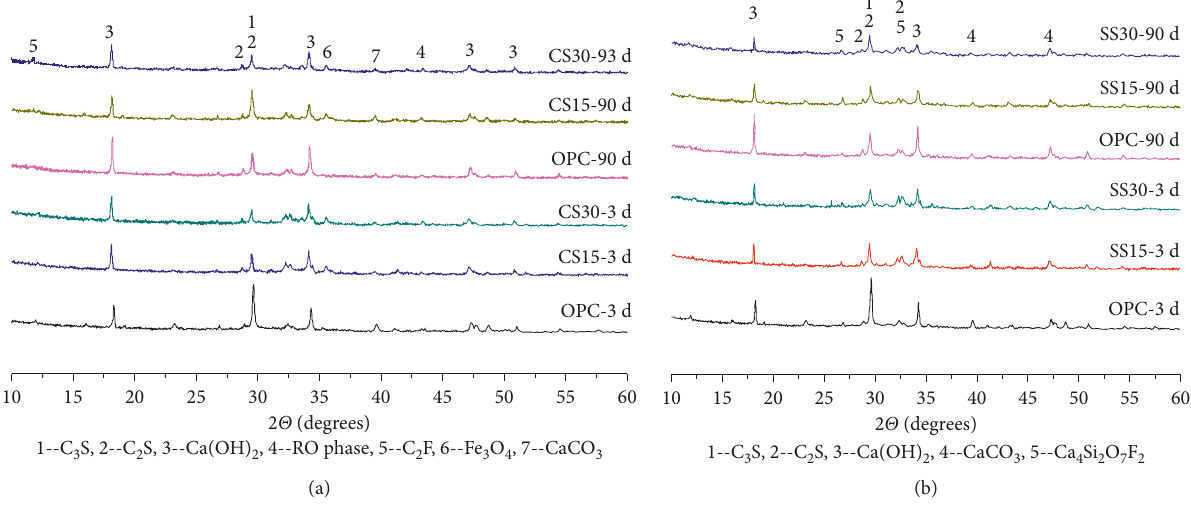
Figure 4: XRD at 3 days and 90 days: (a) OPC, CS15, and CS30; (b) OPC, SS15, and